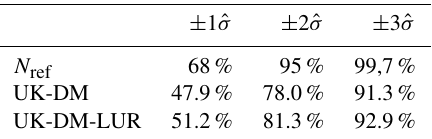
Table 3. Percentages of observations falling in the ±ˆ σ , ± 2 ˆ σ , ± 3 ˆ σ confidence intervals, using all stations in LOOCV during 2019. Confidence intervals are computed based on the hourly predicted values and their standard